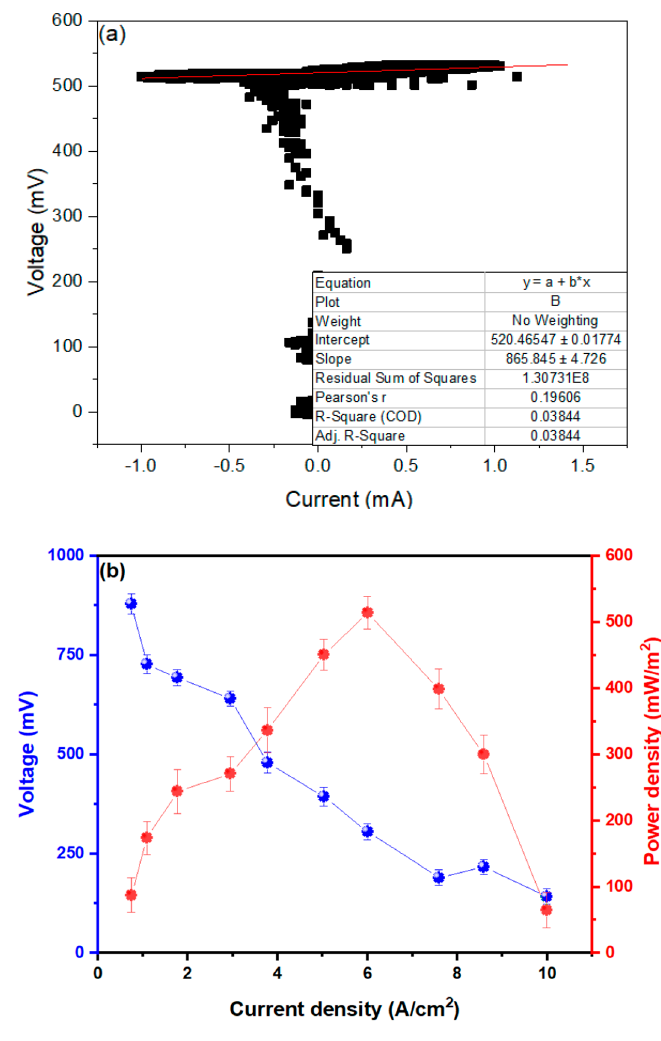
Figure 3. Characterization of ( a ) internal resistance and ( b ) power and voltage density in relation to current density of